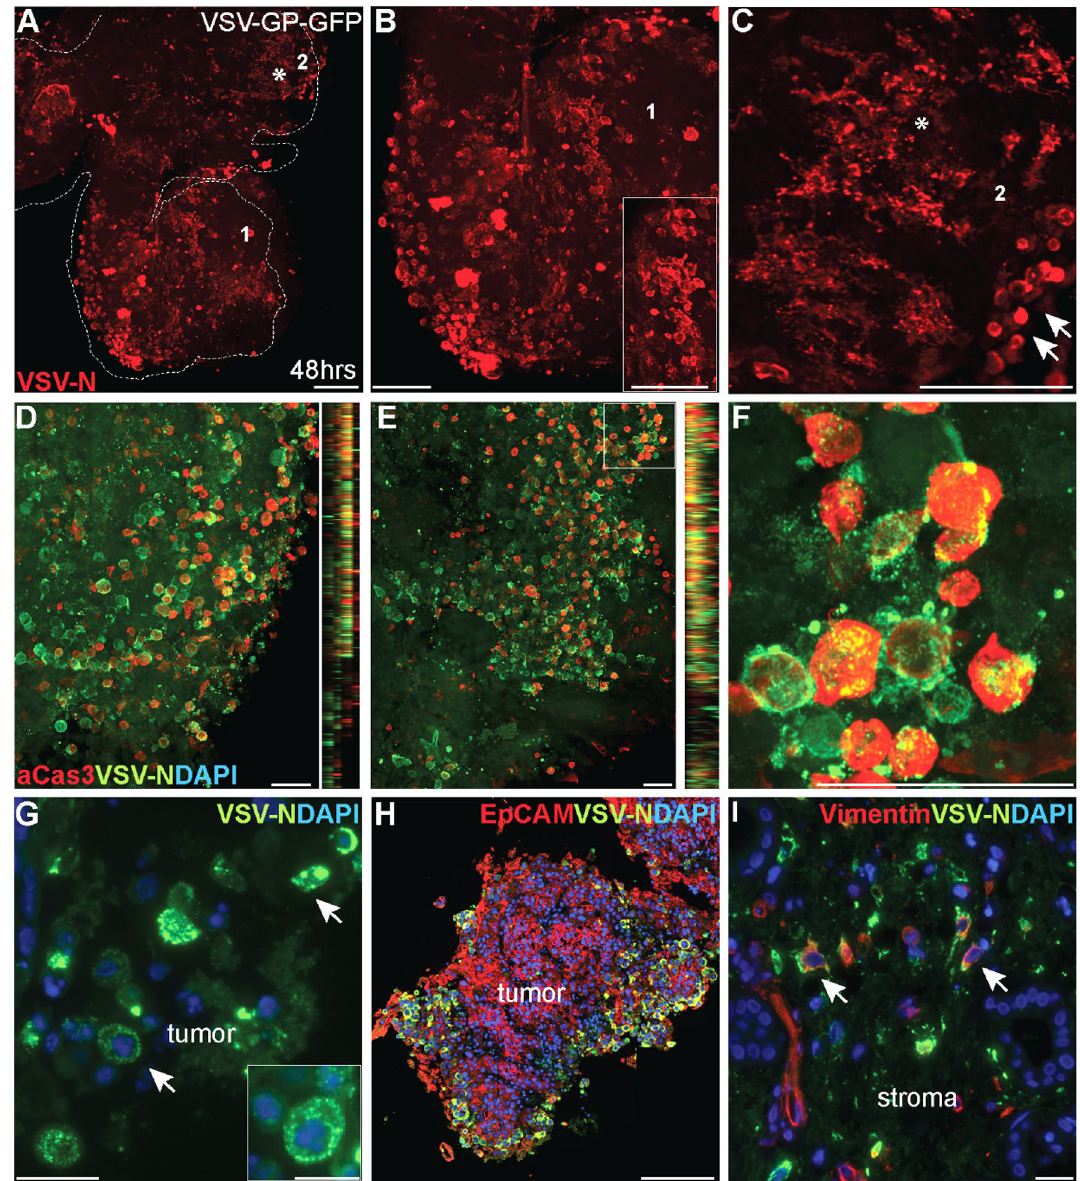
Figure 5. Mode of action of the oncolytic virus VSV-GP in patient-derived HNSCC slice cultures. ( A – C ) Whole mount staining using VSV-N antibody (red) on OV treated HNSCC slice cultures at 48 hpi. Samples were cultivated under air–liquid conditions. Virus spread could be monitored throughout the entire slice ( A ). Rounded cells were detected (higher magnification in ( B ) (1), arrows in ( C ) (2) adjacent to virus positive cell debris ( C , (2), asterisks). Scale bars represent 200 µm. ( D – F ) Co-immunofluorescent stainings of VSV-N (green) and aCas3 (red) were performed on two different whole-mounted OV-treated slices 48 hpi. Maximal projections (xy, yz) showed the presence of active Caspase-3 in VSV-N+ve cells (higher magnification in F ). Scale bars represent 50 µm. VSV-N+ve virus factories ( G , VSV-N-green) were localized in the cytoplasm of thin sections derived from OV-treated HNSCC slice cultures. Scale bars represent 20 µm and 10 µm in the insert. ( H , I ) Virus (VSV-N-green) could be detected in the EpCAM+ve tumor cell compartment (EpCAM-red, H ). Some VSV-N+ve cells co-localized with Vimentin (red) in the tumor stroma ( I ). DAPI (blue) was used as nuclear counterstain. Scale bars represent 20